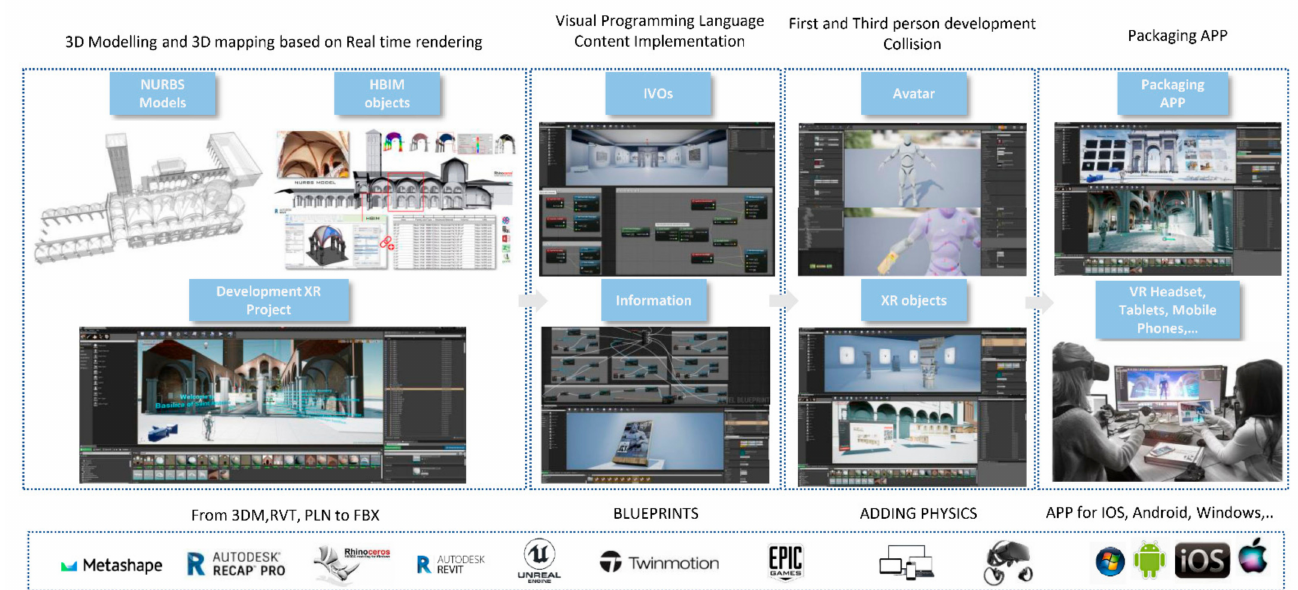
Figure 16. Digital workflow applied to Basilica di Sant’Ambrogio from digital models (NURBS models and HBIM), interactive virtual objects (IVOs), virtual museums and multiple